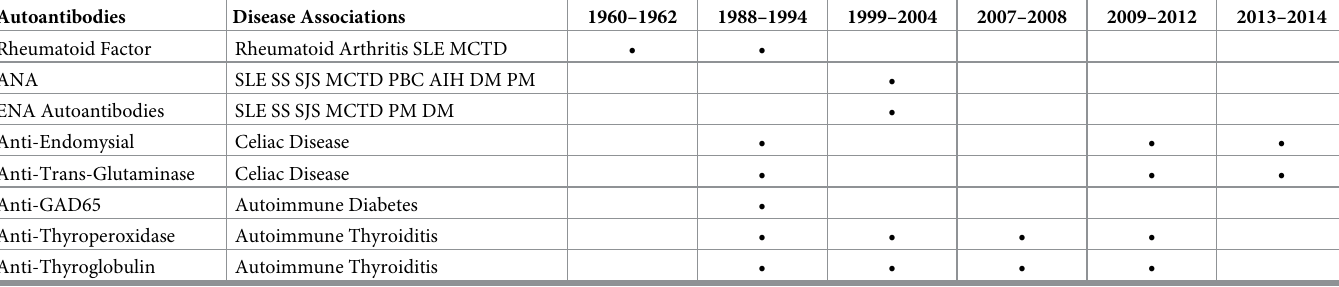
Table 1. US National Health & Nutrition Examination Survey autoantibody Data,